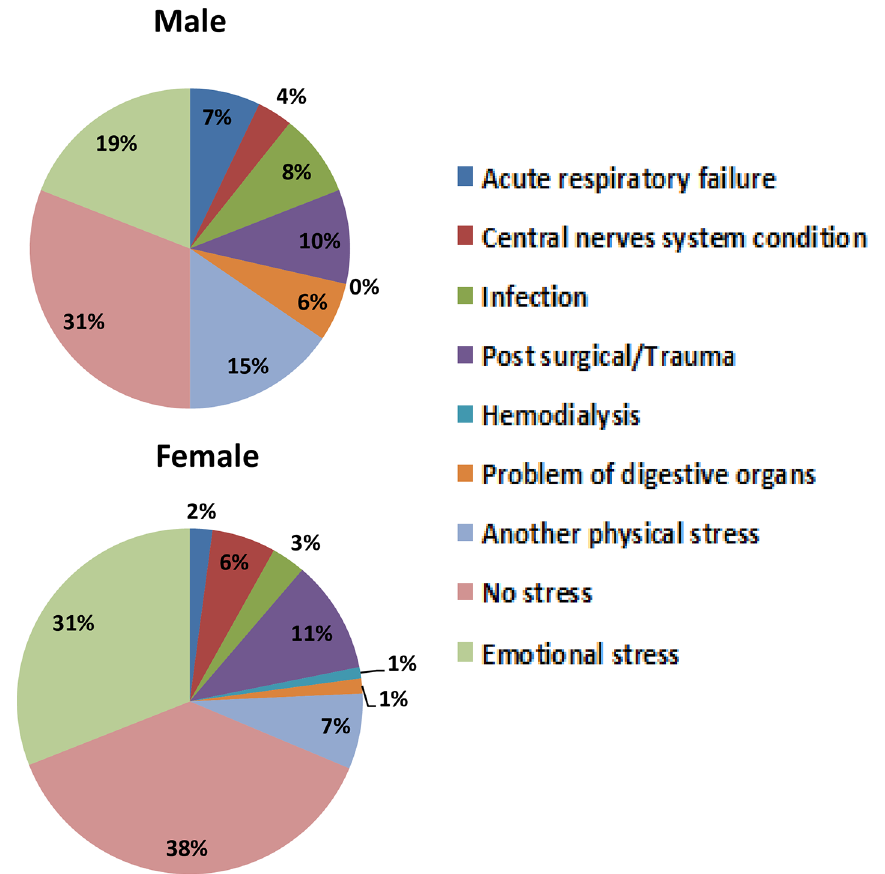
Fig 1. Preceding physical and emotional stresses displayed by